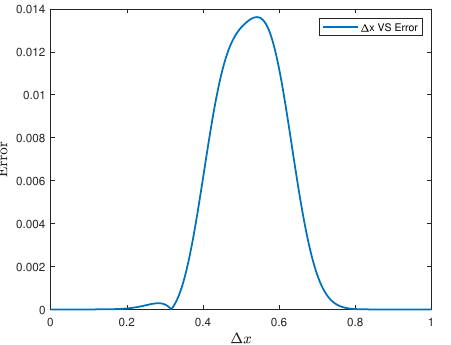
Figure 8. Absolute error between the exact and EUPFD solutions against